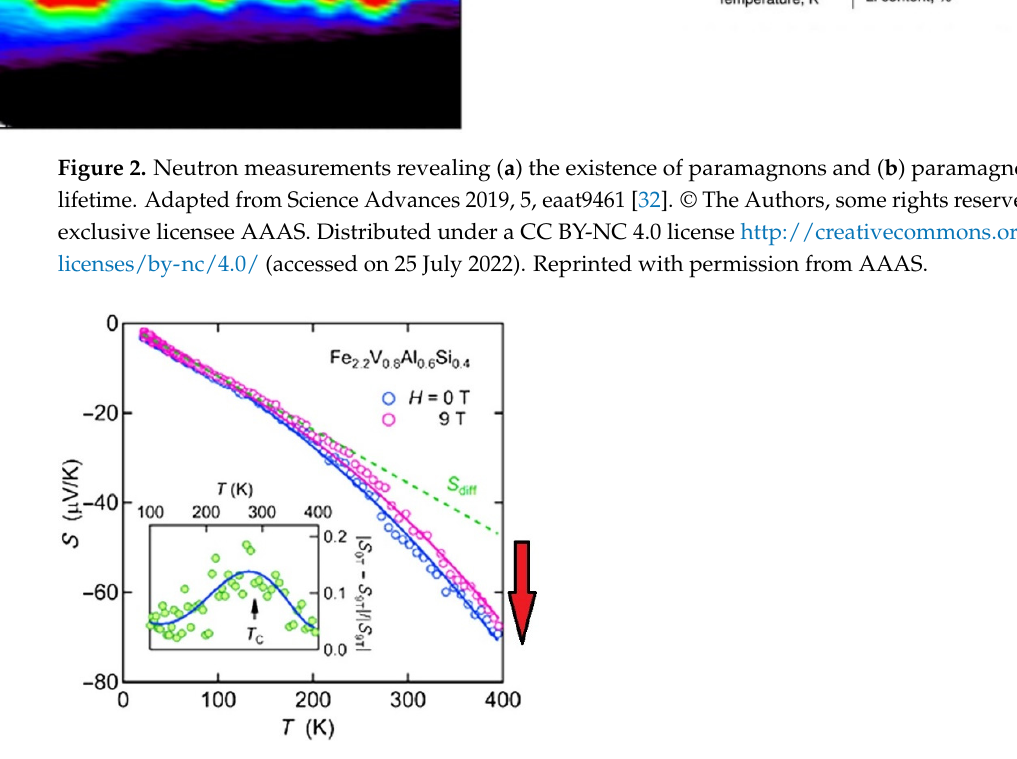
Figure 2. Neutron measurements revealing ( a ) the existence of paramagnons and ( b ) paramagnon lifetime. Adapted from Science Advances 2019, 5, eaat9461 [32]. © The Authors, some rights re- served; exclusive licensee AAAS. Distributed under a CC BY-NC 4.0 license http://creativecom- mons.org/licenses/by-nc/4.0/ (accessed on 25 July 2022). Reprinted with permission from AAAS.